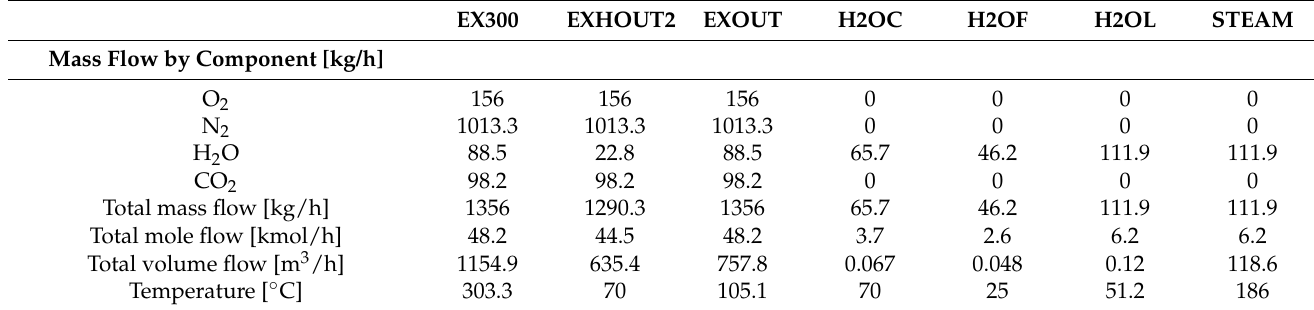
Figure 7. T–Q diagrams of the heat exchange process in the HRSG unit. Table 7. Streams’ properties of the optimized HRS for a 300 kW SOFC plant.